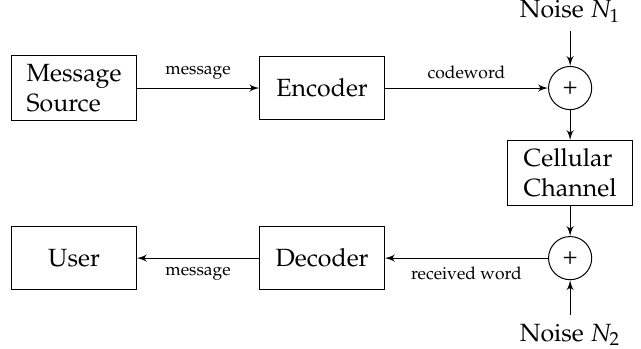
Figure 4. Noisy subthreshold cardiac communication channel